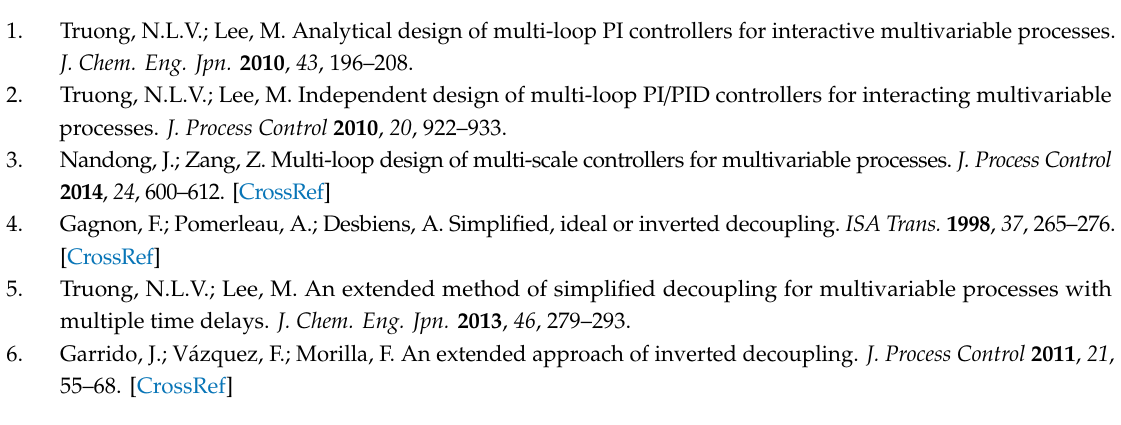
Figure 26. The implementing diagram of the DSP structure for OR column